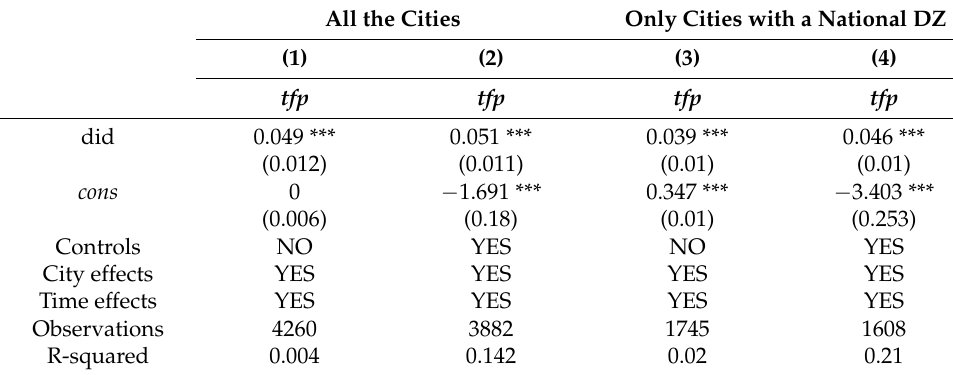
Table 12. Impact of Ecoregion Establishment on TFP.